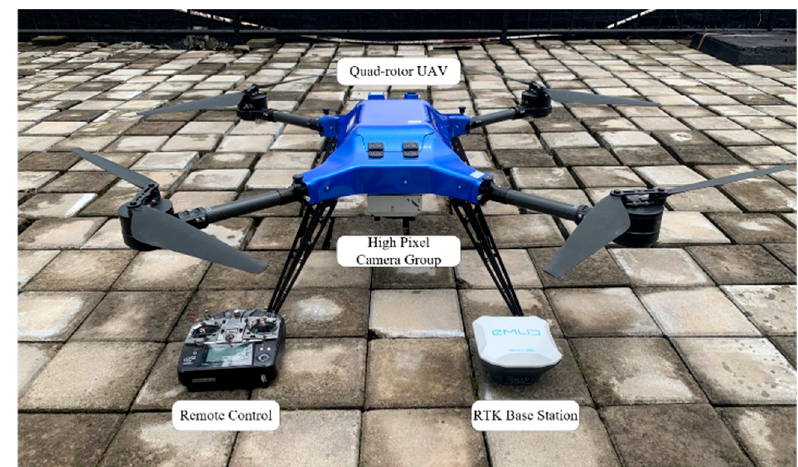
Figure 11. Quad-rotor UAV.